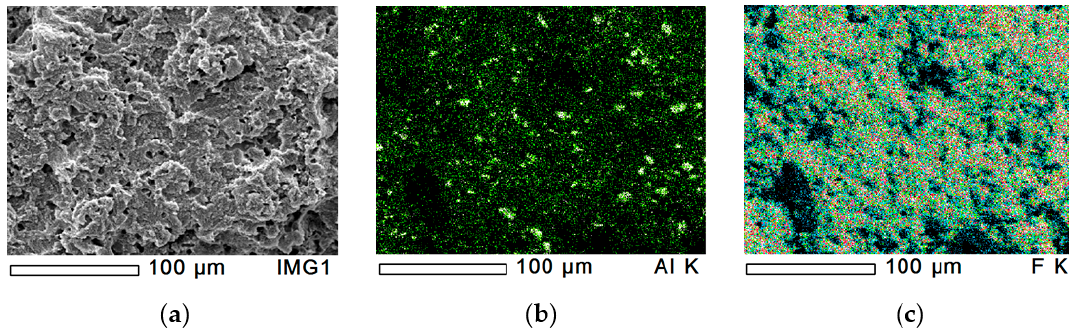
Figure 2. EDS analysis of PTFE/Al 2 O 3 -4 sample with 500× magnification. ( a ): original cryo-fractured surface, ( b ): aluminium content and ( c ): fluorine content.